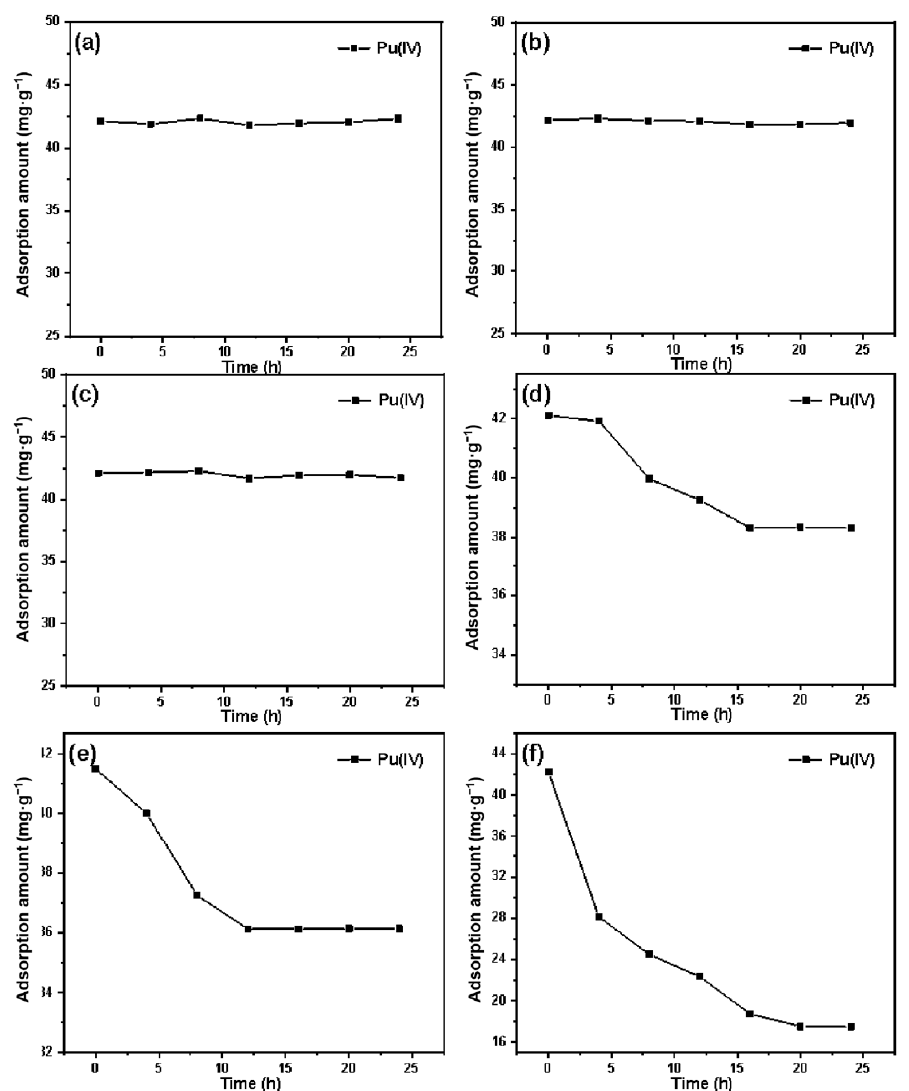
Figure 22. Adsorption of Pu(IV) by SG-VTS-VPQ treated with different concentrations of HNO 3 . ( a ) adsorption of Pu(IV) by SG-VTS-VPQ treated with 1 mol · L − 1 HNO 3 ; ( b ) adsorption of Pu(IV) by SG-VTS-VPQ treated with 3 mol · L − 1 HNO 3 ; ( c ) adsorption of Pu(IV) by SG-VTS-VPQ treated with 5 mol · L − 1 HNO 3 ; ( d ) adsorption of Pu(IV) by SG-VTS-VPQ treated with 7 mol · L − 1 HNO 3 ; ( e ) adsorption of Pu(IV) by SG-VTS-VPQ treated with 8 mol · L − 1 HNO 3 ; ( f ) adsorption of Pu(IV) by SG-VTS-VPQ treated with 9 mol · L − 1 HNO 3 .